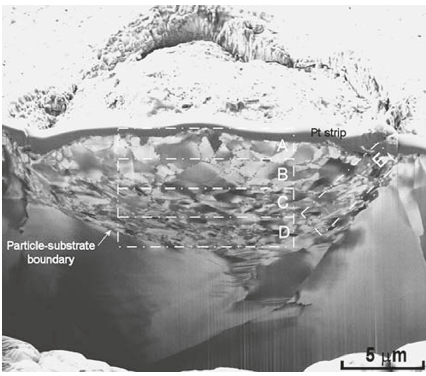
Figure 2: FIB-SEM imaging of the cross section of a Cu particle depositing onto a Cu substrate [17].